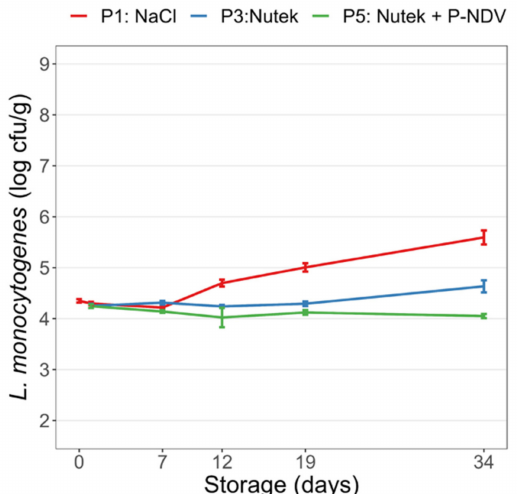
Figure 7. Growth of L. monocytogenes in industrially produced CS salmon with NaCl, sodium reduced salt (Nutek), and combined Nutek and Provian NDV preservative salt (products P1, P3, P5, respectively; Table 2). The CS salmon were inoculated at Day 0 and stored under vacuum at 4 ◦ C for 34 days. Mean values of six analysed samples and standard errors of the mean are